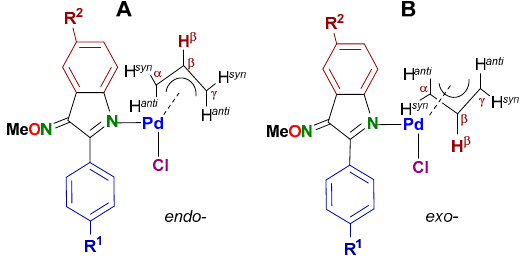
Figure 2. Schematic view of the two isomeric forms ( A) ( endo- ) and ( B) ( exo -) of compounds [Pd( η 3 -C 3 H 5 ){C 8 H 3 N-2-(C 6 H 4 -4-R 1 )-3-NOMe-5-R 2 }Cl] [R 1 = OMe and R 2 = H ( 2a ), R 1 = R 2 = H ( 2b ) or R 1 = H, R 2 = Cl ( 2c )].